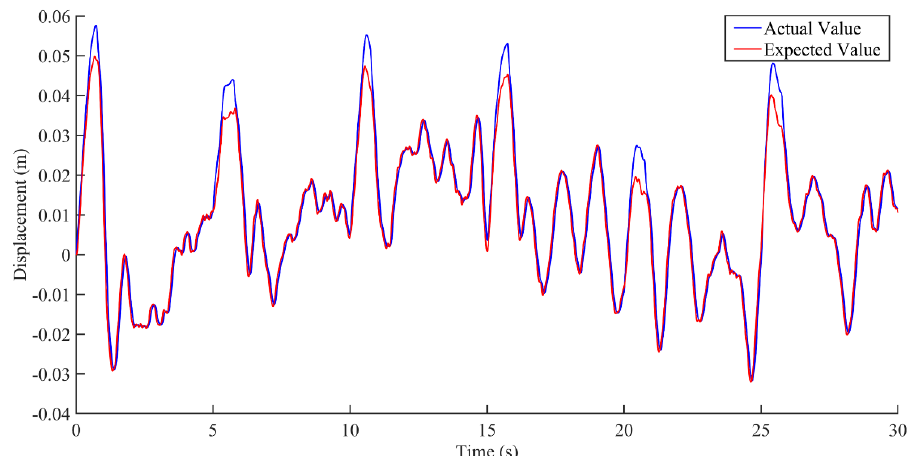
Figure 14. Acceleration comparison under the condition of no interference.